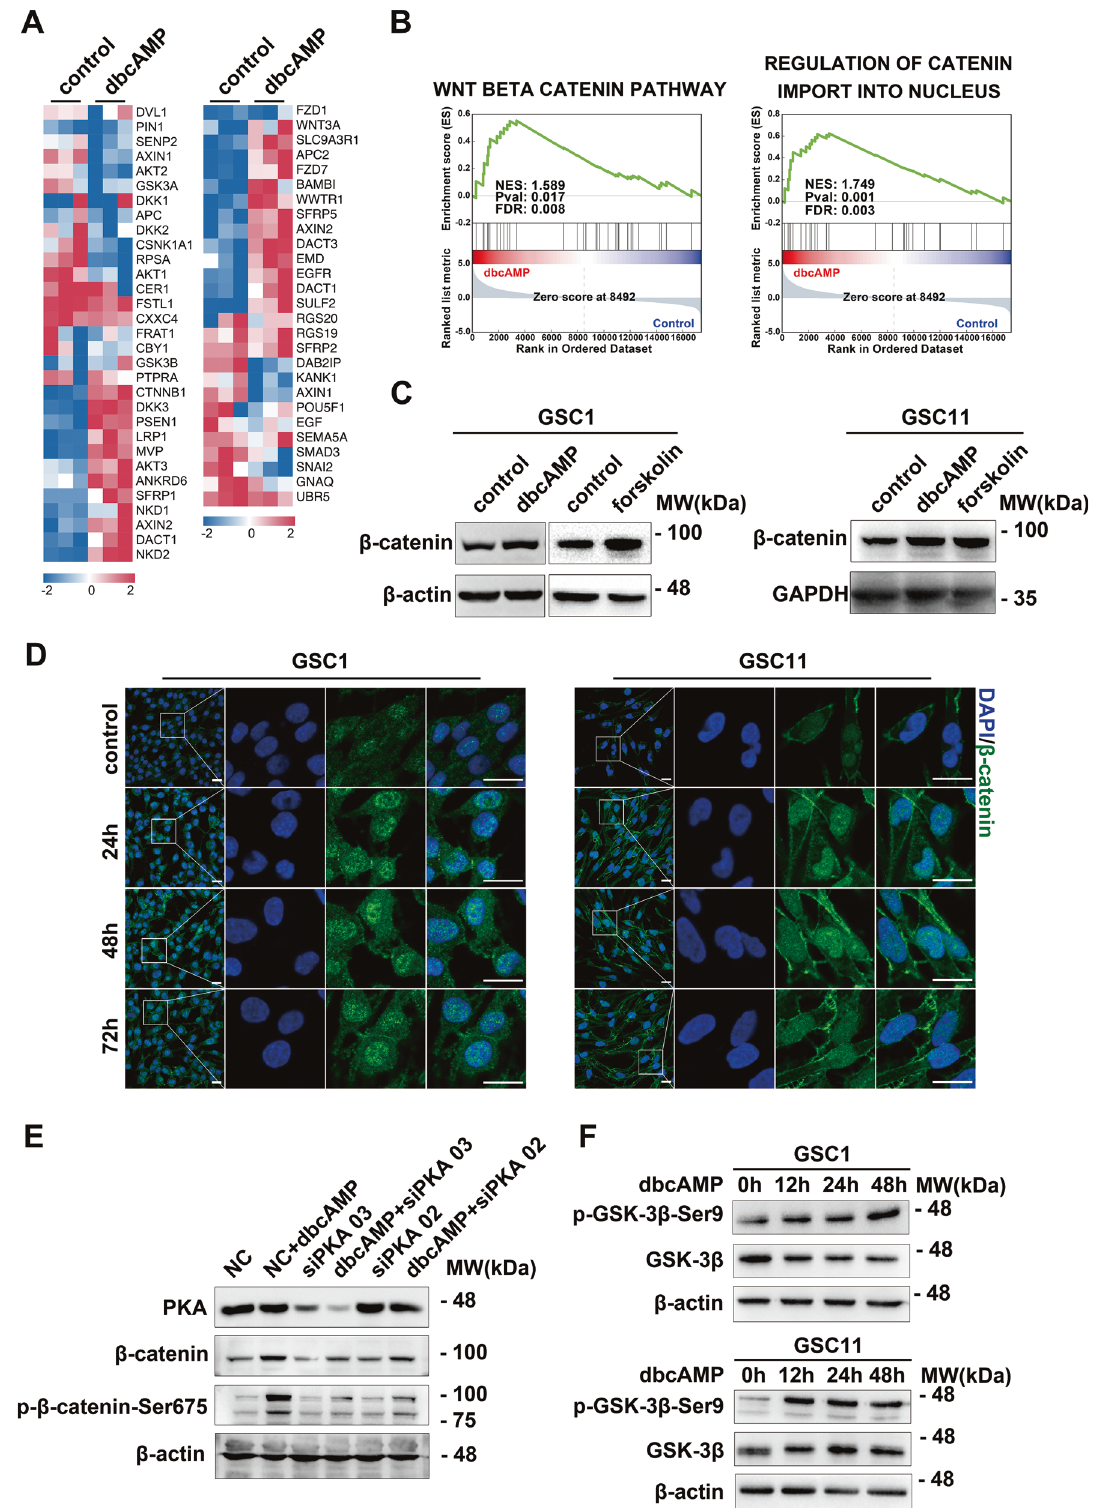
Fig. 3 cAMP activates β -catenin signaling by inhibiting destabilization of β -catenin through PKA and GSK-3 β . A Heat map of DEGs between GSCs treated with and without dbcAMP. B GSEA analysis using the mRNA sequencing data. C Western blot of β -catenin protein in GSCs incubated with dbcAMP and forskolin. D Immuno fl uorescence staining of β -catenin (green) in GSCs treated with dbcAMP at 0 (control), 24, 48, and 72 h. E Western blot of total and phosphorylated β -catenin in GSCs subjected to different treatments. F Protein level of phosphorylated GSK-3 β at Ser9 and GSK-3 β assessed by Western blot in GSCs treated with dbcAMP at 0, 24, 48, and 72 h. (Scale bar, 25 μ m).